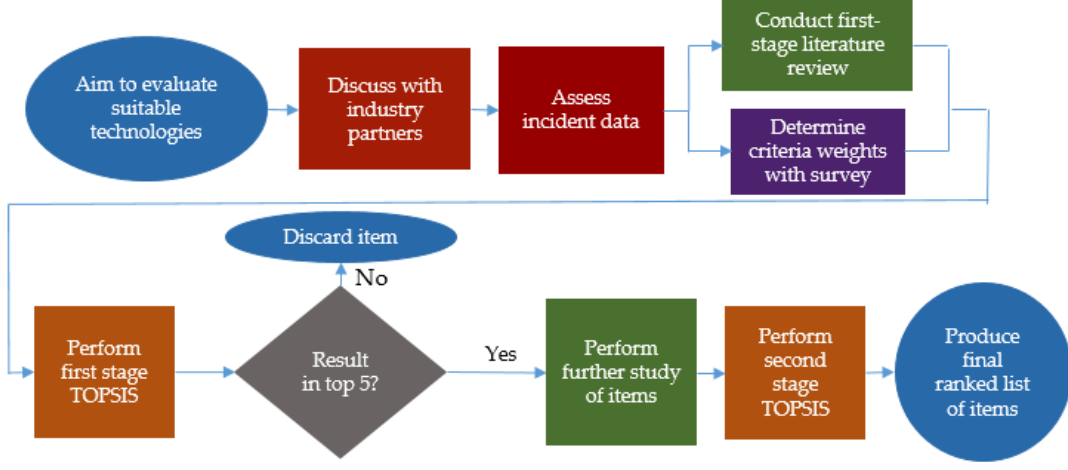
Figure 5. Flowchart outlining methodology employed in this work.